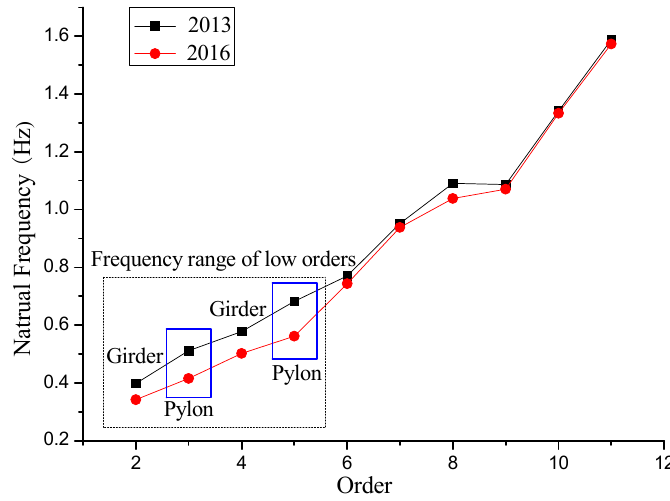
Figure 7. Disparity of natural frequencies between two measurements.